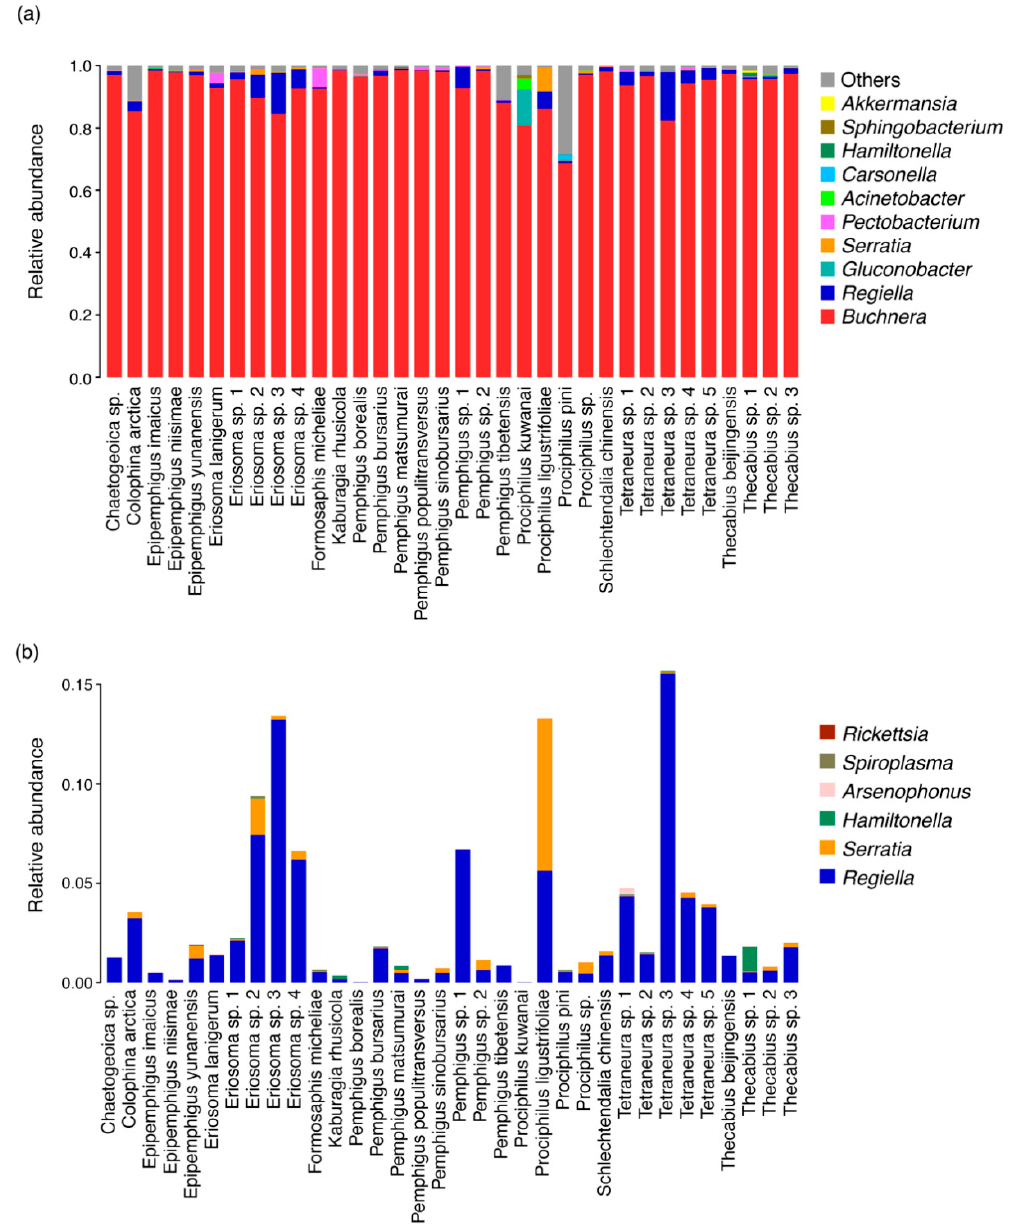
Figure 1. Bar plots of all bacteria ( a ) and facultative symbionts ( b ) associated with Eriosomatinae.